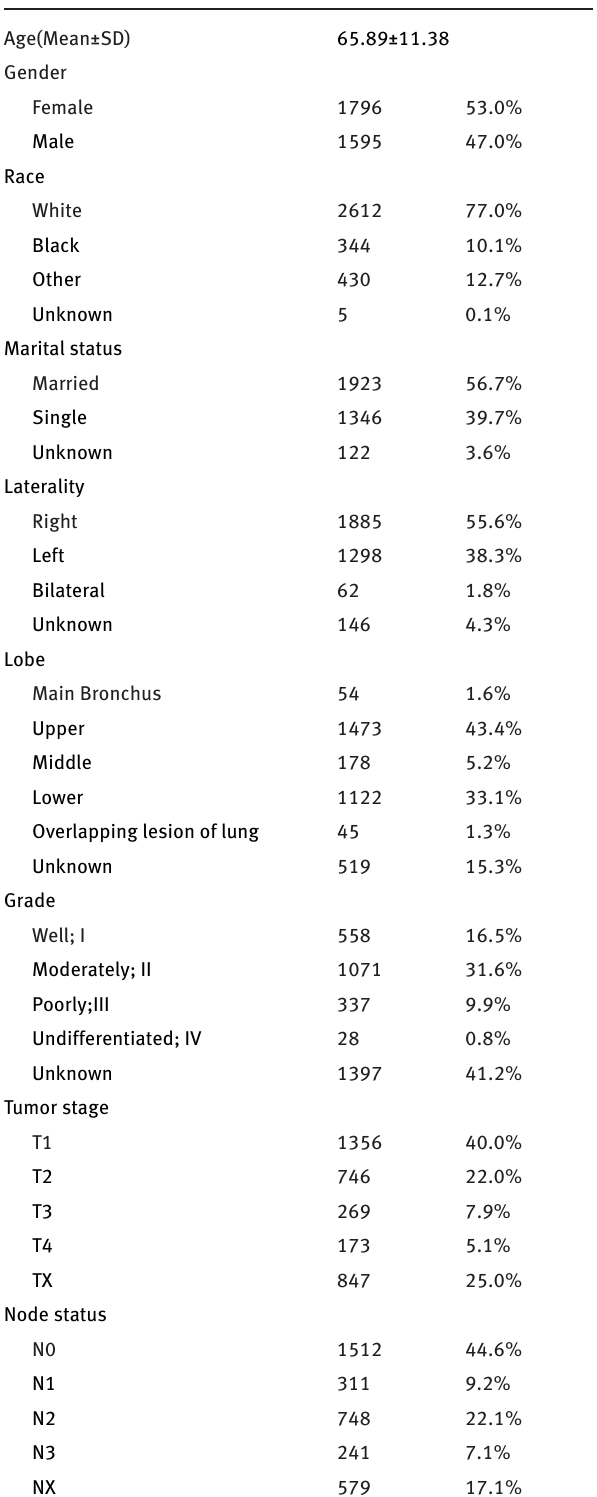
Table 1: Characteristics of patients with papillary adenocarcinoma